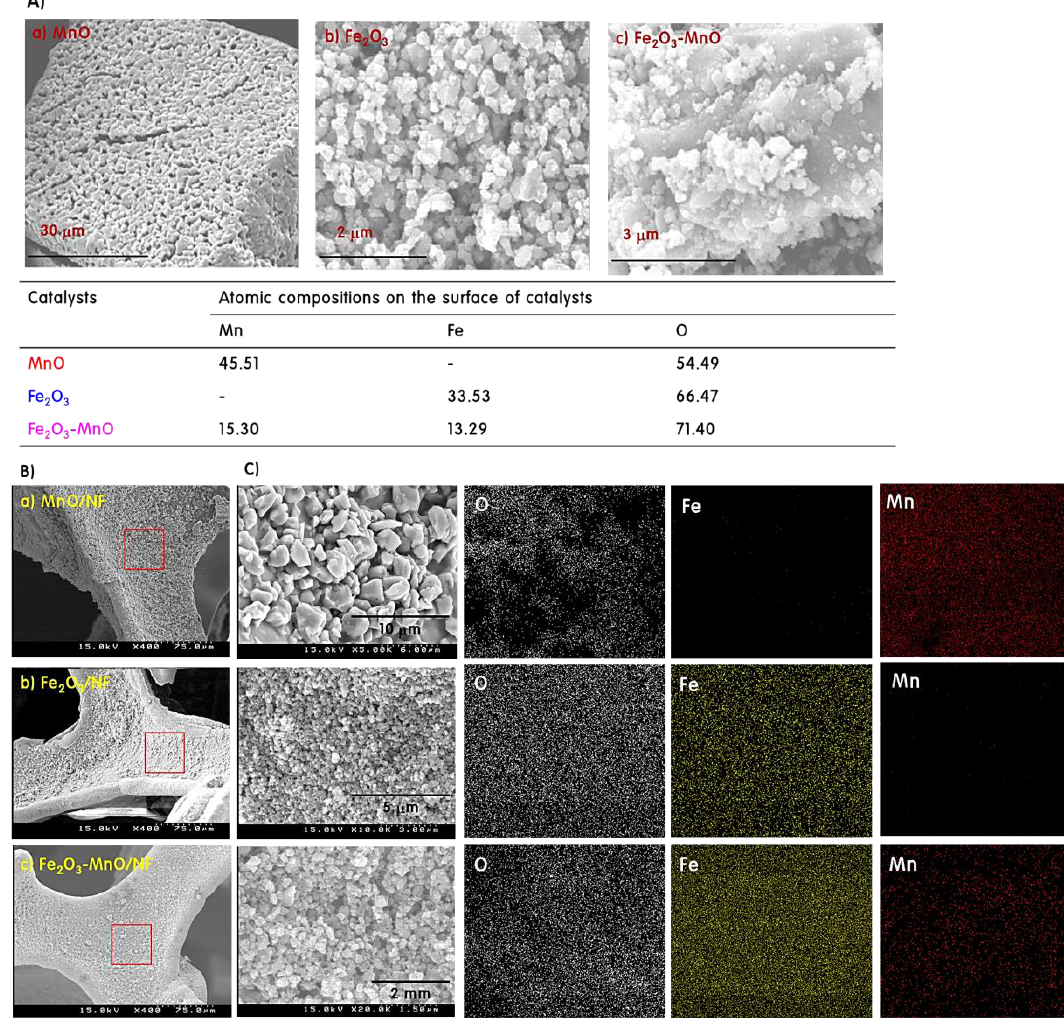
Figure 2. Energy-dispersive X-ray spectroscopy (EDS) analysis of selected surfaces of the film-type electrodes ( A ), and the images of scanning electron microscopy (SEM) ( B ) and element mapping on the surface of the electrode ( C ).